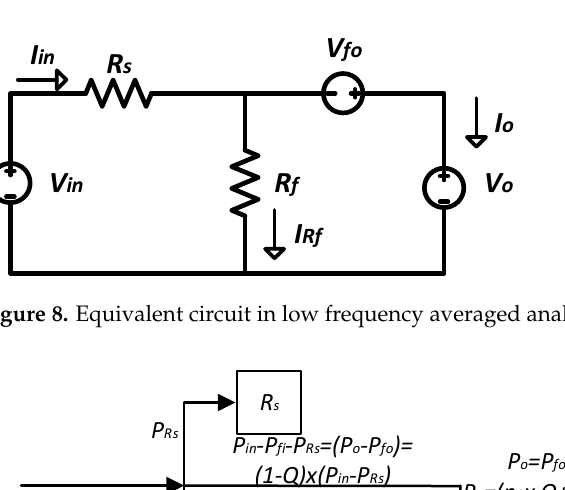
Figure 7. Modified flyback converter for thermoelectric generators.